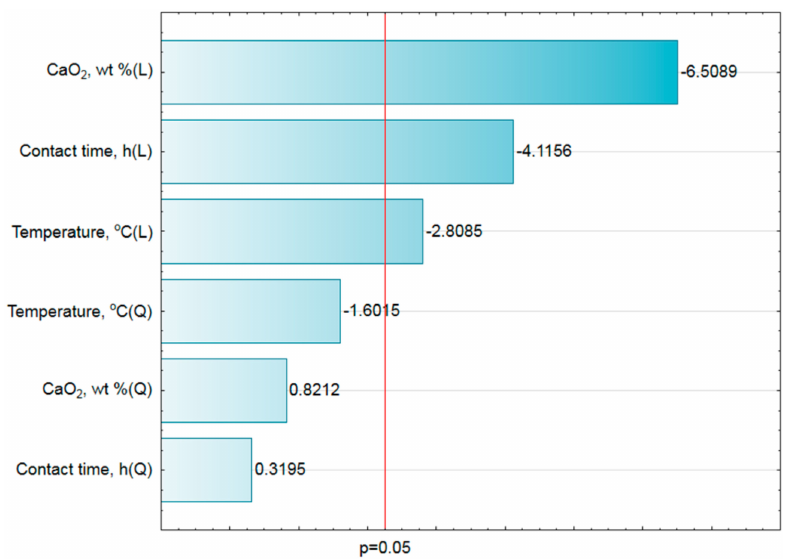
Figure 2. Bar-chart of the absolute value of standardized assessment of the effects ( E. coli , log 10 CFU/g, 3 value, 1 block, 16 experiments, MS = 0.3877). L—linear effect and Q—quadratic effect. The lengths of the horizontal bars represent the estimators values of standardized effects from the highest to the lowest while the vertical line shows absolute value of the standardized effect ( p = 0.05).